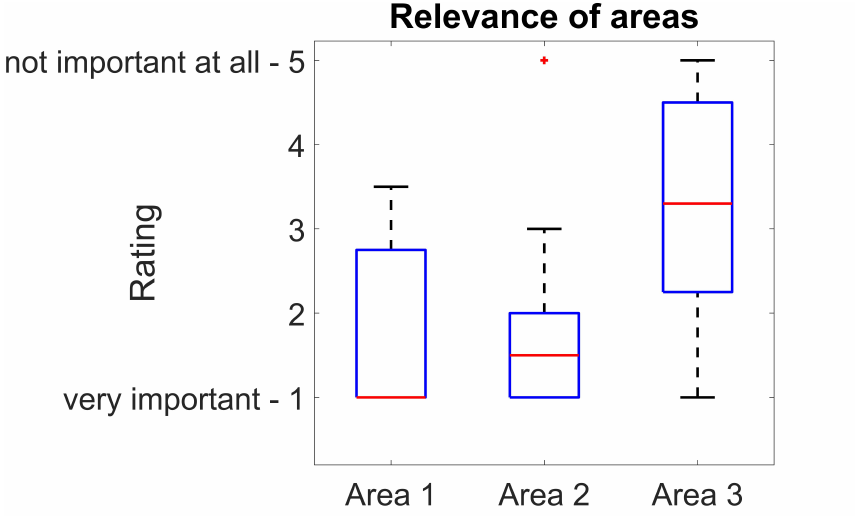
Figure 6. Relevance ratings for the three different evaluation areas in the vehicle’s forefield obtained for the static case, 0kmh − 1 ). The near-field and mid-field areas seem to be more important for the brightness evaluation than the far-field